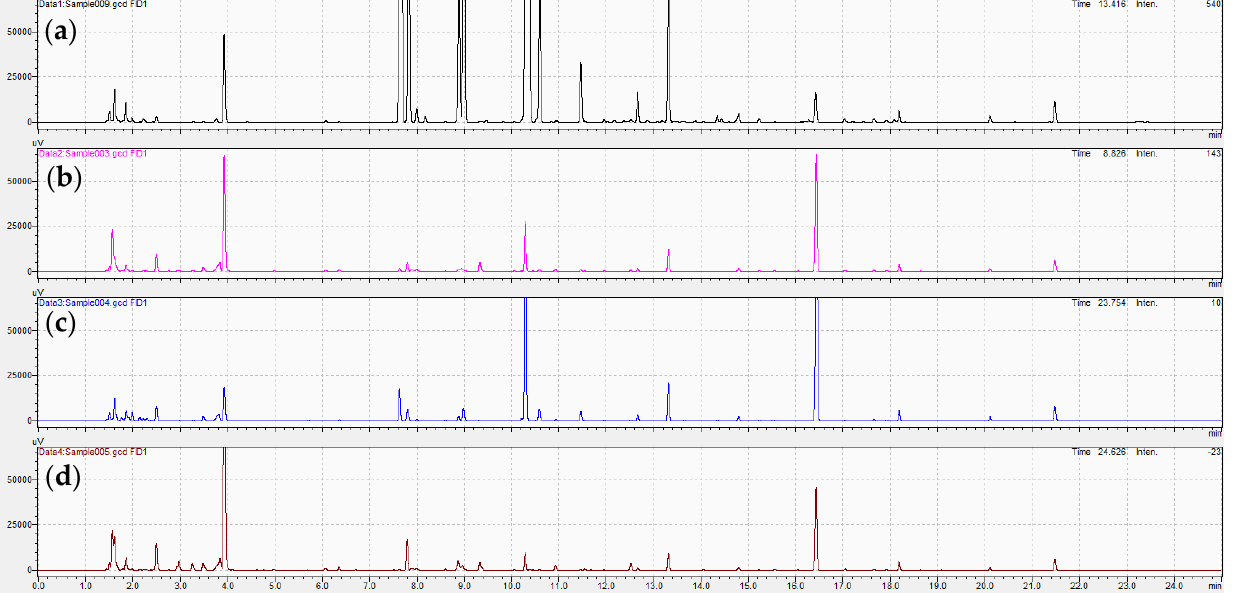
Figure 2. The GC chromatograms of ( a ) n -hexane, ( b ) oil obtained from Soxhlet extraction of milled raw seed (Oil SE ), and ( c ) the extracted oil obtained from a screw press machine (Oil SM ). The y-axis is normalized to the similar maximum intensity of 10.0 × 10 4 µV. 3.2. Volatile Figerprints of Black Cumin Seed Oil Obtained from SCCO 2 Extraction The chromatograms of black cumin seed oil extracted by SCCO 2 at 20.0 MPa and 30.0 MPa are revealed in Figures 3 and 4, respectively.